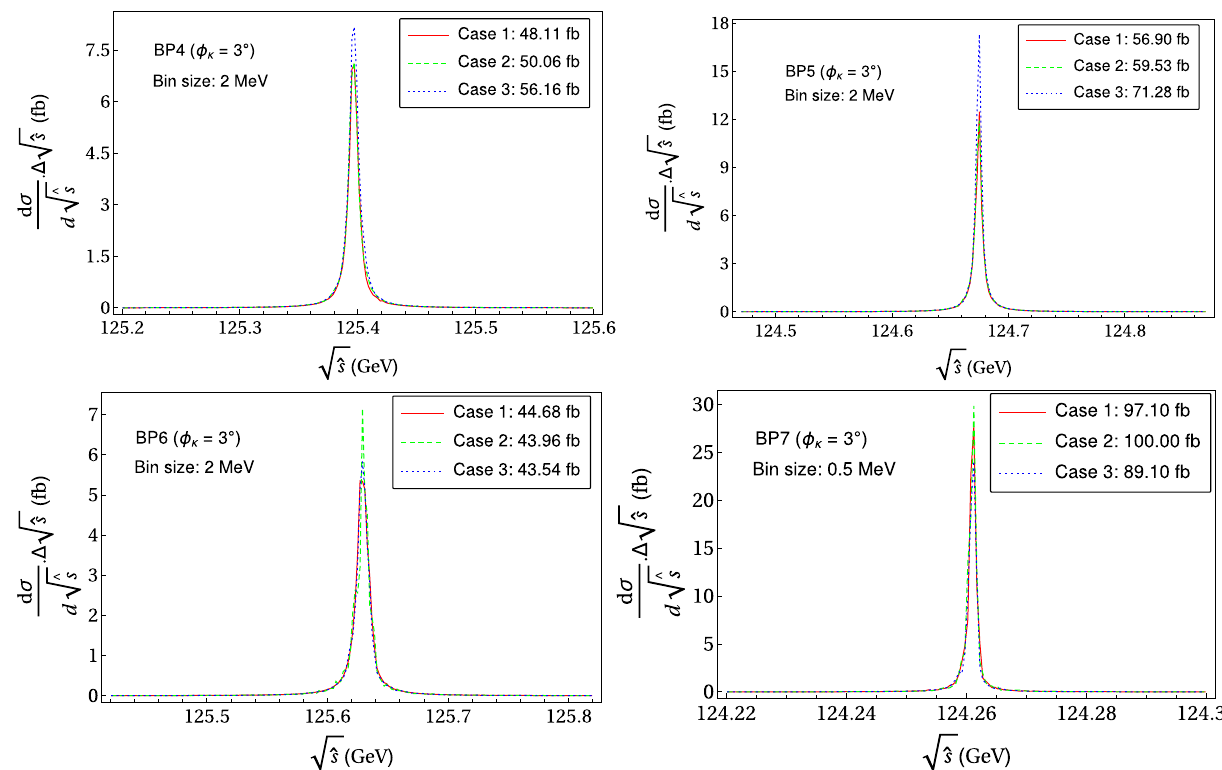
Fig. 4 As in Fig. 3, for the BPs corresponding to the cNMSSM with φ κ = 3